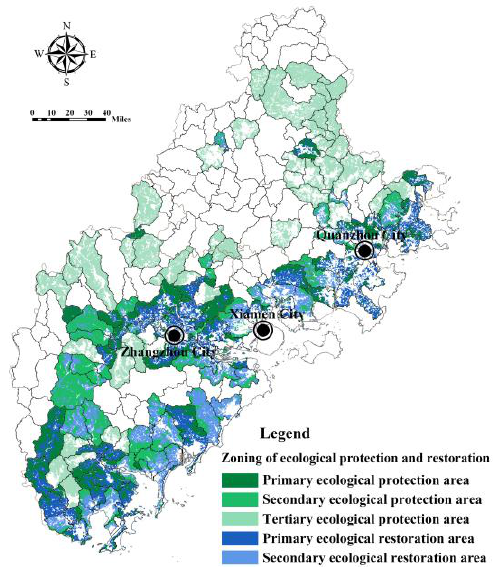
Figure 15. Zoning management of ecological space in Fujian Delta based on the comparison of FRES supply and demand in the sub-basin.